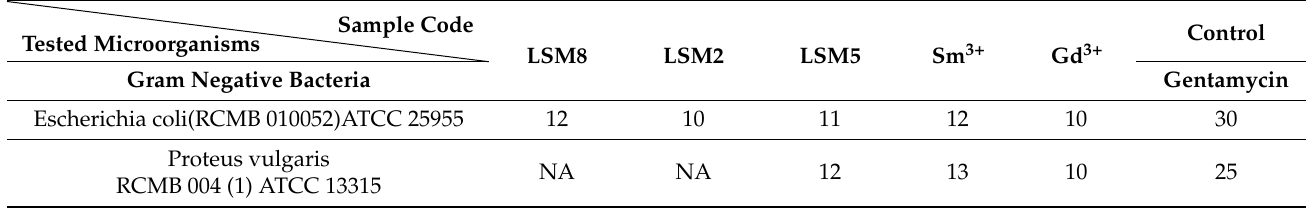
Table 1. Activity of LSM samples at different conditions as antimicrobial agents. Sample Code Tested